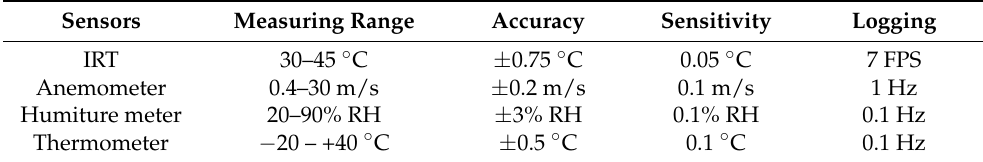
Figure 3. Optical image and infrared thermography fused in one picture. Table 1. Sensors and